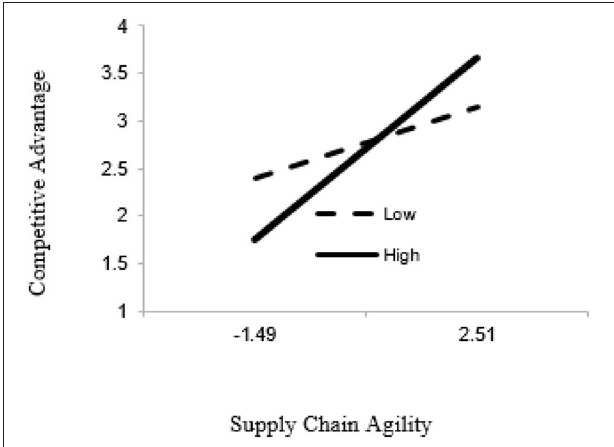
FIGURE 2 | Interaction (SCA*INF →